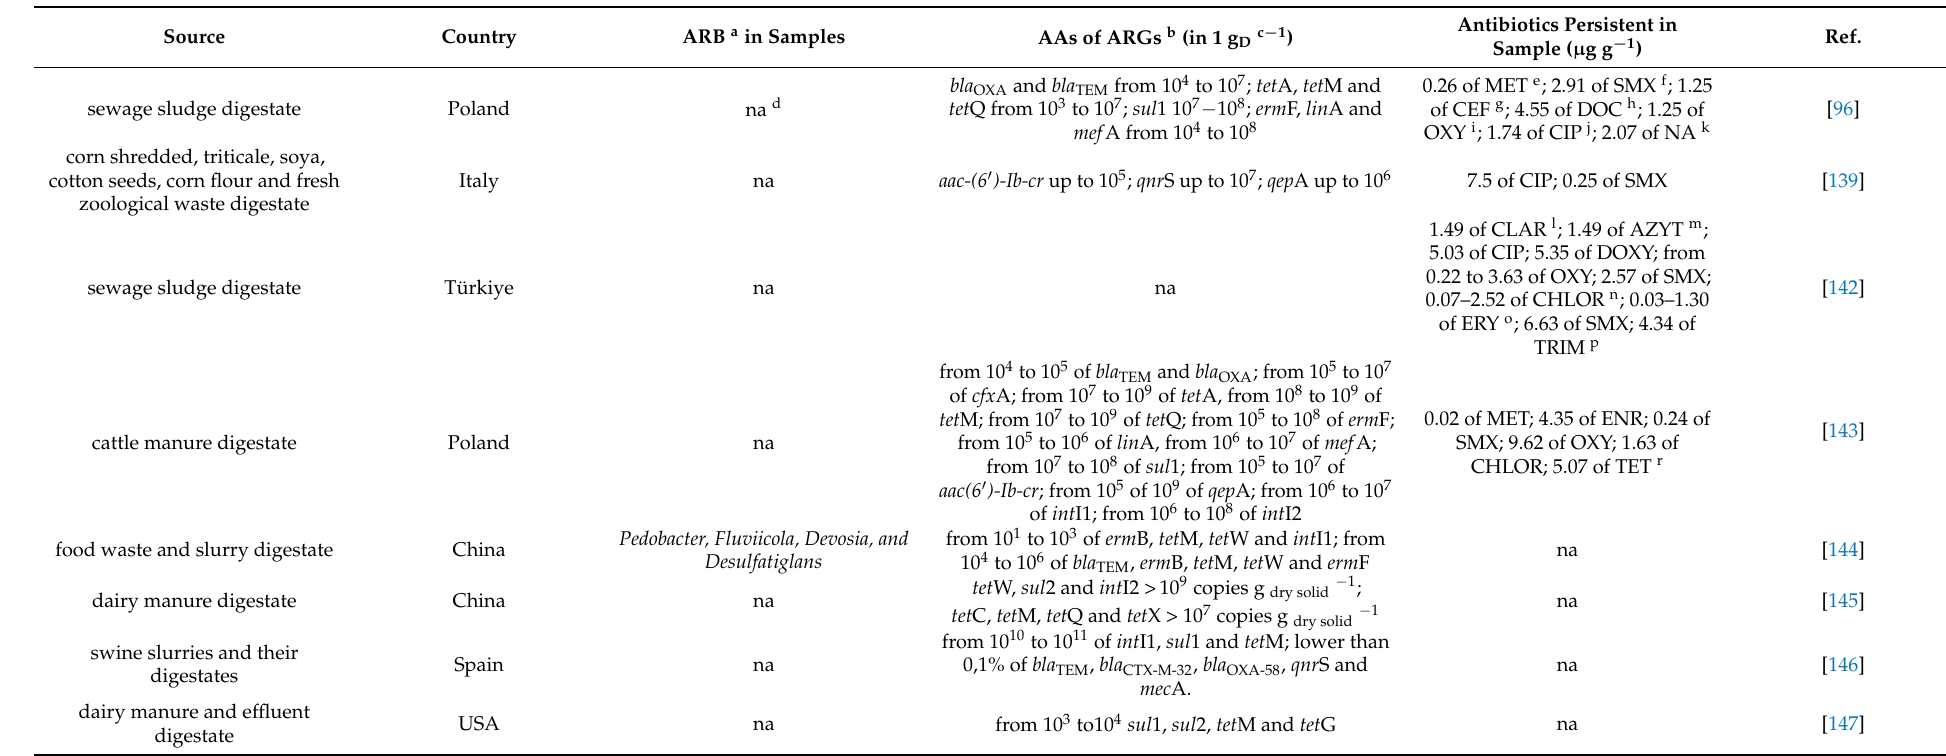
Table 8. Data on the presence of antibiotics, ARB and ARGs in various digestate materials from AD